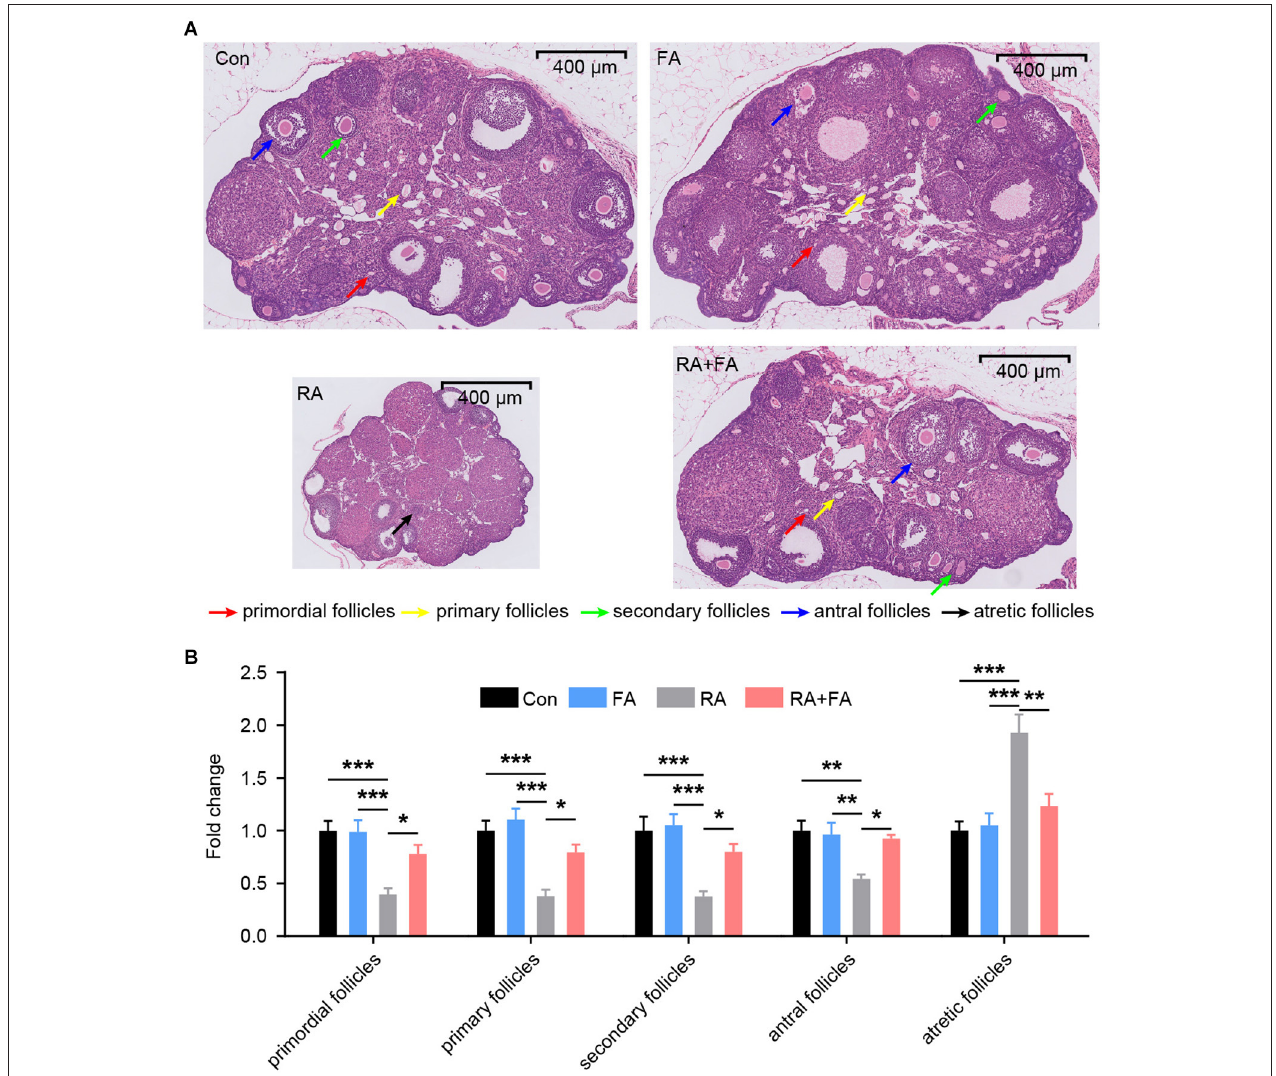
FIGURE 2 | Effect of folic acid (FA) pre-administration on ovarian pathological damage after radiation injury. (A) The results of hematoxylin and eosin (H&E) staining indicated that FA pre-administration relieved ovarian histopathological damage. Red arrow: primordial follicles; yellow arrow: primary follicles; green arrow: secondary follicles; blue arrow: antral follicles; black arrow: atretic follicles. Scale bar, 400 µ m. (B) Relative quantification of the ovarian follicles for each group. There was no significant difference in follicle number between the Con group and FA group ( p > 0.05). The numbers of primordial follicles, primary follicles, secondary follicles, and antral follicles in the RA group were significantly lower than those in the Con group. FA pre-administration significantly relieved the effect of radiation on the ovarian tissue structure and increased the number of ovarian follicles, thus enhancing ovarian reserve capacity. Con: control group, FA, FA pre-administration control group; RA, radiation exposure group; RA + FA, FA pretreatment + radiation exposure group. Error bars, standard error of mean (SEM). N = 7, * p < 0.05, ** p < 0.01, and *** p <